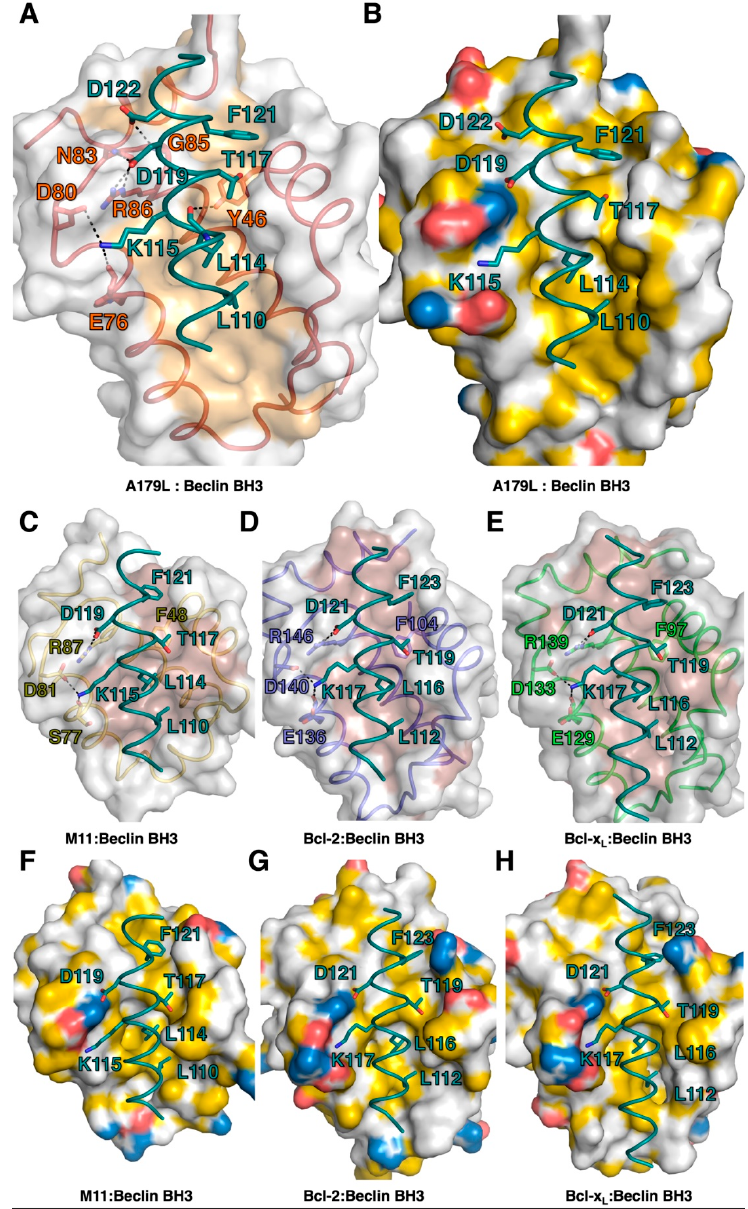
Figure 7. Detailed view of the interfaces of pro-survival Bcl-2 protein complexes with Beclin BH3. ( A ) A179L is shown as a grey molecular surface, with the backbone and floor of the binding groove shown in green and orange, respectively. Beclin BH3 is shown in cyan. ( B ) Surface representation of A179L bound to Beclin BH3. A179L surface is shown in grey, charged residues are shown in blue and red, hydrophobic residues in yellow. Beclin BH3 is shown as cyan sticks. ( C ) γ -herpesvirus 68 M11 (orange) in complex with the human Beclin BH3 motif (cyan) (PDB ID:3BL2). ( D ) Human Bcl-2 (blue) in complex with the human Beclin BH3 motif (cyan) (PDB ID:5VAU). ( E ) Human Bcl-x L (green) in complex with human Beclin BH3 motif (cyan) (PDB ID:2P1L). All views in (C)–(E) are as in (A). Hydrogen bonds and ionic interactions are shown as black dotted lines. ( F ) Surface representation of M11 bound to Beclin BH3. M11 surface is shown in grey, charged residues are shown in blue and red, hydrophobic residues in yellow. Beclin BH3 is shown as cyan sticks. ( G ) Surface representation of Bcl-2 bound to Beclin BH3. M11 surface is shown in grey, charged residues are shown in blue and red, hydrophobic residues in yellow. Beclin BH3 is shown as cyan sticks. ( H ) Surface representation of Bcl-x L bound to Beclin BH3. M11 surface is shown in grey, charged residues are shown in blue and red, hydrophobic residues in yellow. Beclin BH3 is shown as cyan